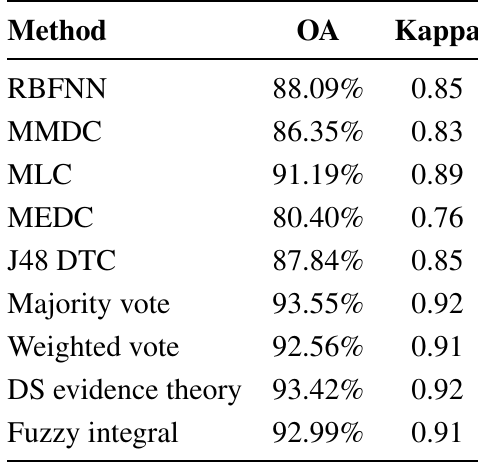
Table 11. Classification accuracies of Landsat ETM + image.